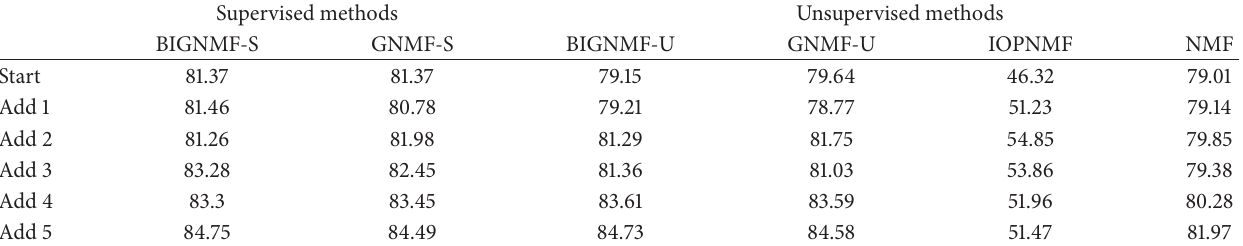
Table 4: The recognition rates (%) for the CMU-PIE database during adding 5 batches of images belonging to different classes. Supervised methods